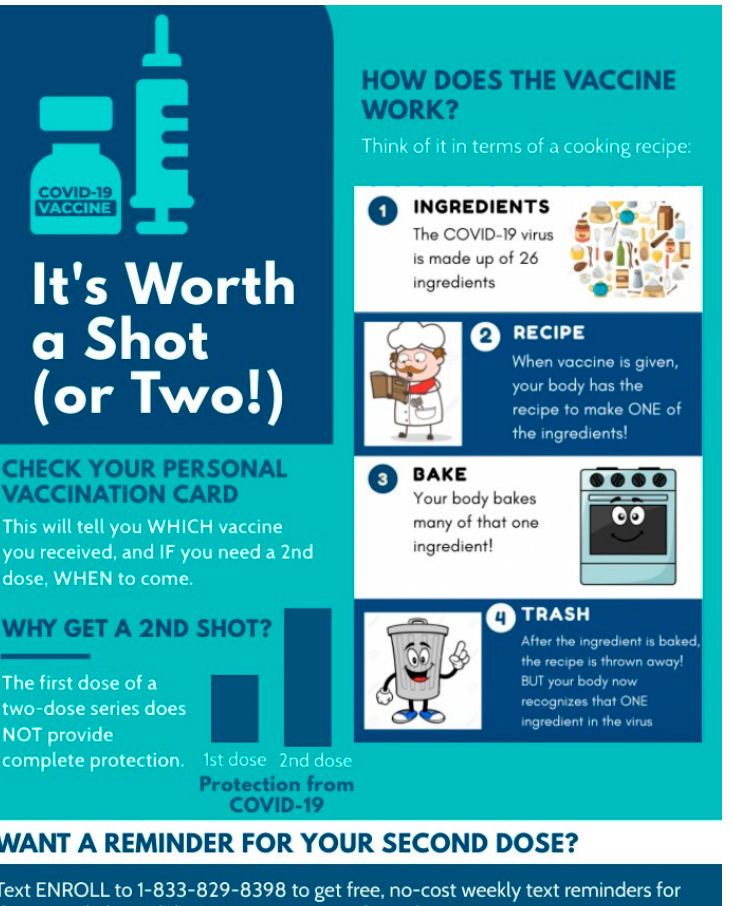
Figure 1. COVID-19 infographic created for distribution at the Lincoln Park COVID-19 vaccine POD in Los Angeles, CA. The infographic uses analogies and pictograms to explain in lay terms how the vaccine works.